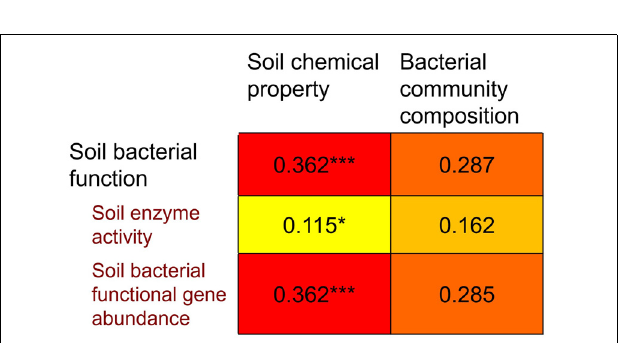
FIGURE 6 | Spearman’s rank correlations ( r -values), determined via Mantel test, relating to Bray-Cutris distance dissimilarity matrices generated from soil bacterial community composition at genus level, and to Euclidean distance dissimilarity matrices generated from soil chemical property and soil microbial function. Soil microbial function is further divided into two categories: soil enzyme activity and soil bacterial functional gene